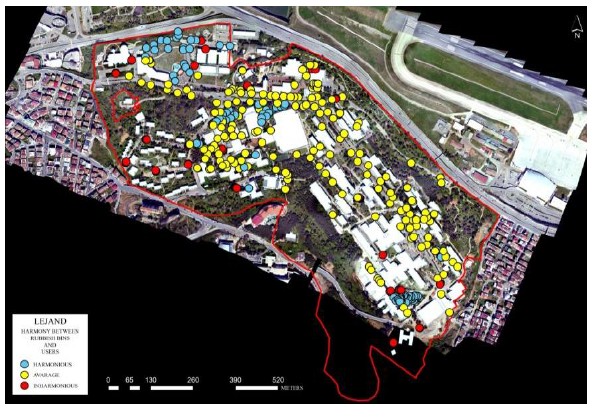
Figure 3. Harmony between Rubbish Bins and